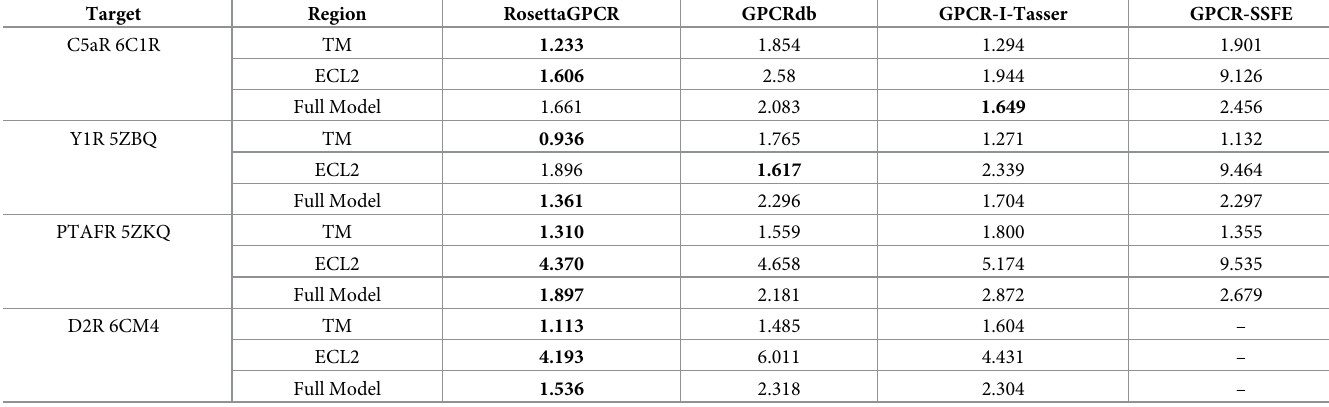
Table 1. Results of Novel Structure Prediction from Various GPCR Modeling Servers. Blind predictions were carried out on C5aR1 (PDB ID 6C1R [39]), Y1R (PDB ID 5ZBQ [40]), PTAFR (PDB ID 5ZKQ [41]), and D2R (PDB ID 6CM4 [42]). 100 models were generated for each target with RosettaGPCR and the best scoring model was used for analysis. The RMSD of each model for the various servers were calculated for the TM region, ECL2, and the full model. The best performing model in each evaluation criteria is bolded. No data is available for GPCR-SSFE for D2R.